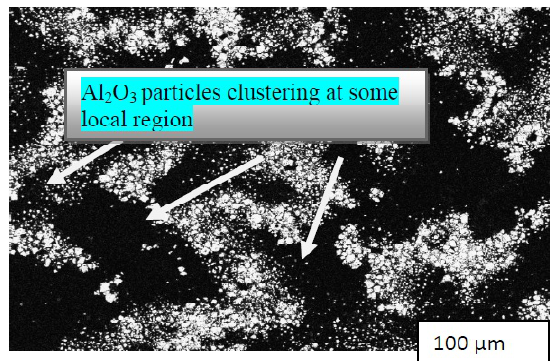
Fig. 7 SEM micrograph of the furnace-cooled sam- ple after sintering at 1000 ° C. The Al (bright) are segregated in some local regions in the Al (Zn) matrix (dark). Reprinted with permission from Peng Yu, Cheng-Ji Deng, Nan-Gang Ma, H.L. Dickon